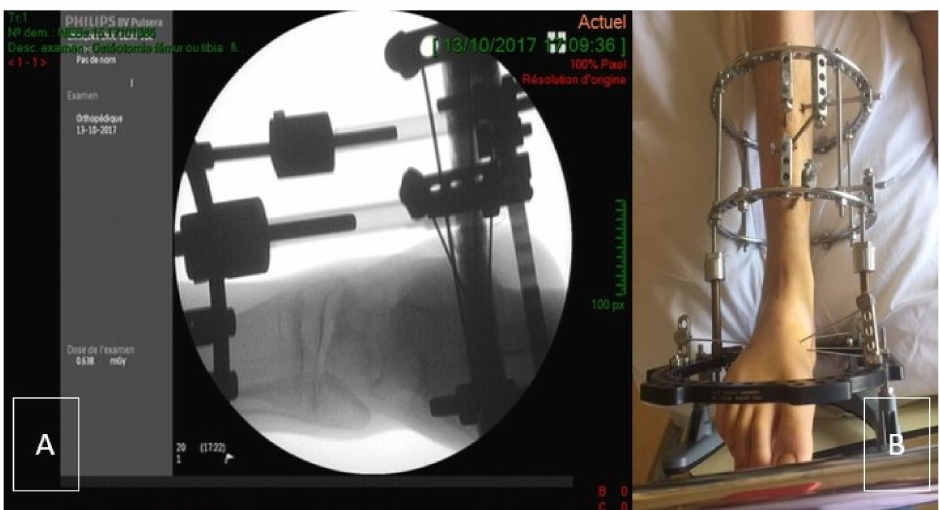
Figure 1. ( A ) Per-operative evaluation of Ilizarov placement using X-ray. ( B ) Clinical picture of the Ilizarov frame (post- surgical status-day